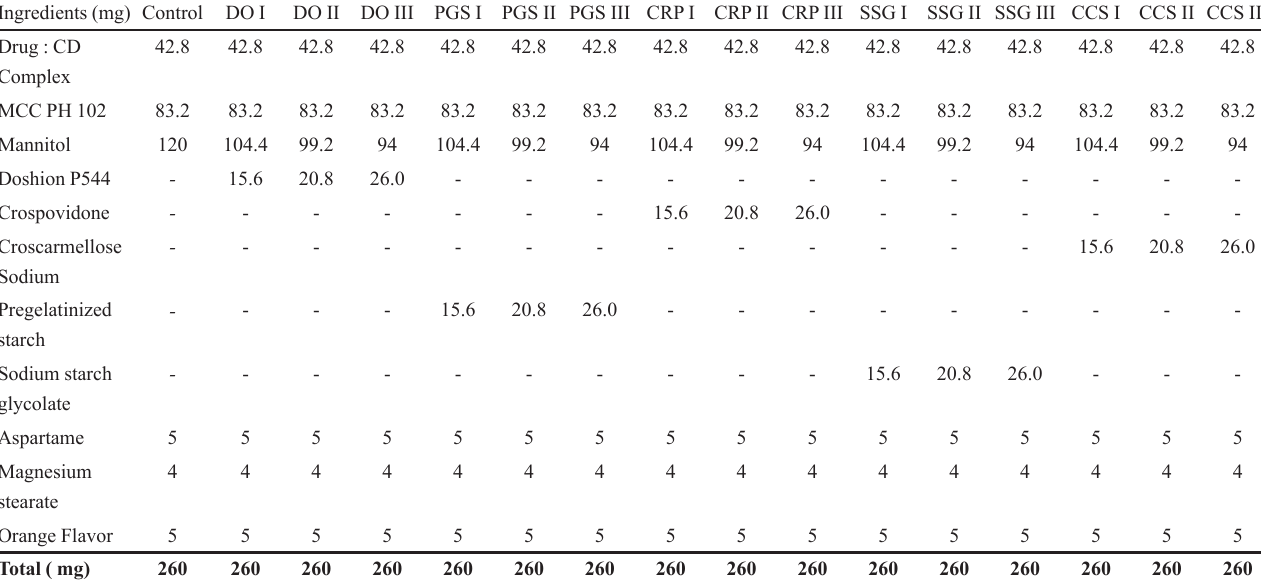
TABLE I - Formulae used in the preparation of tablets Ingredients (mg) Control DO